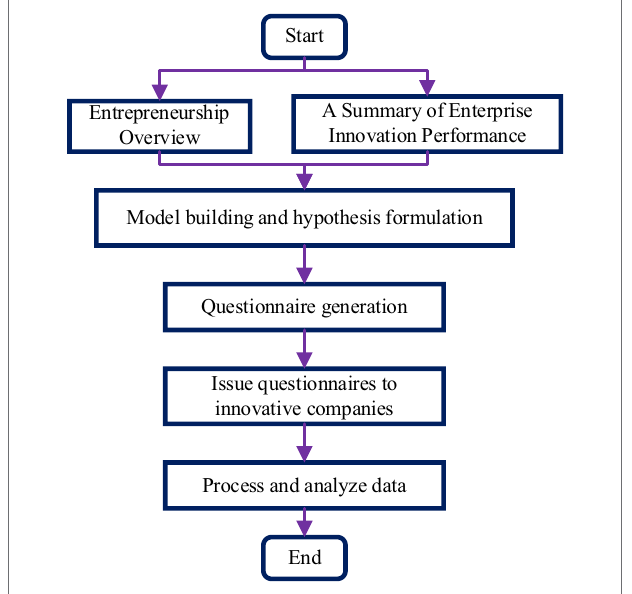
FIGURE 4 | Research